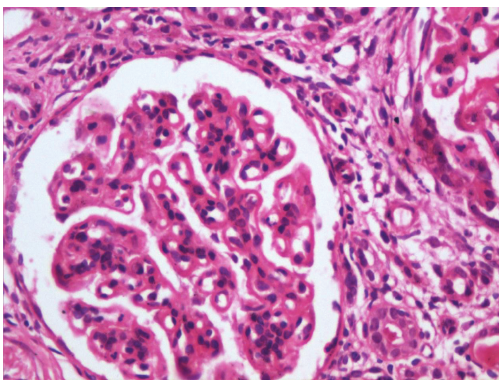
Figure 2: Renal biopsy showing glomerular basement membrane thickening with mesangial proliferation.